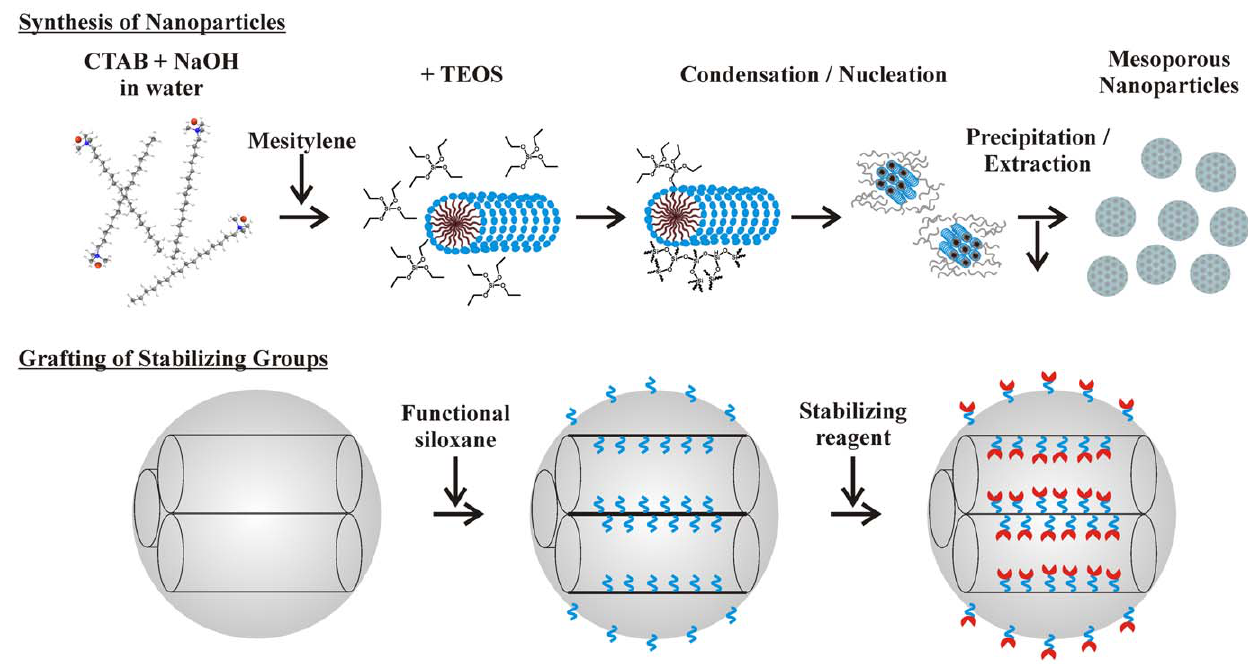
Figure 1. Schematic representations of synthesis and functionalization of nanospherical silicate particles.